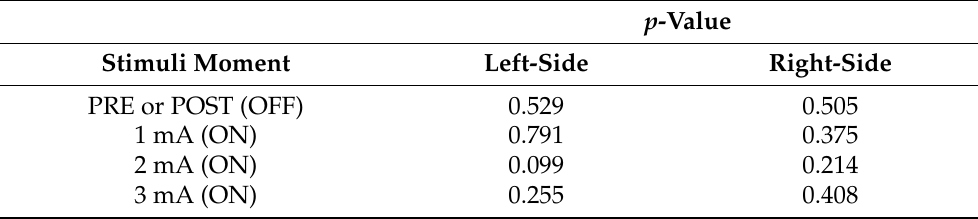
Table 2. Kruskal–Wallis tests considering each force place (information flux comes from the Left- side, Left → Right, or Right-side, Right → Left) across the difference between Sham-Anodal versus Sham-Cathodal stimulation observation per